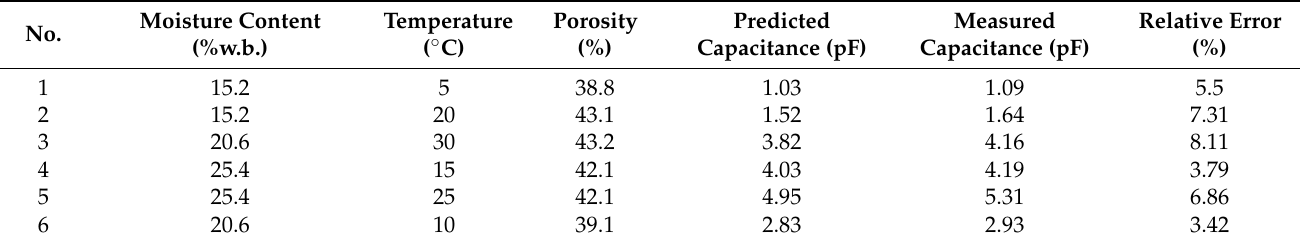
Table 5. Results of validation